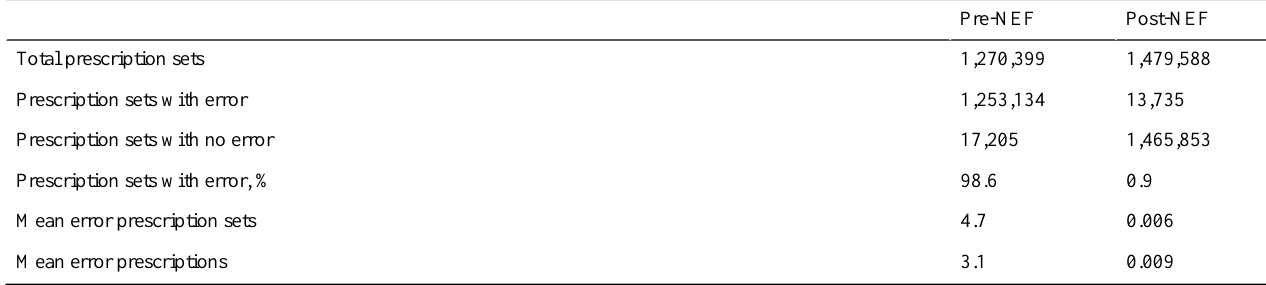
Table 7. Summary of pre-NEF and post-NEF prescription and prescription set